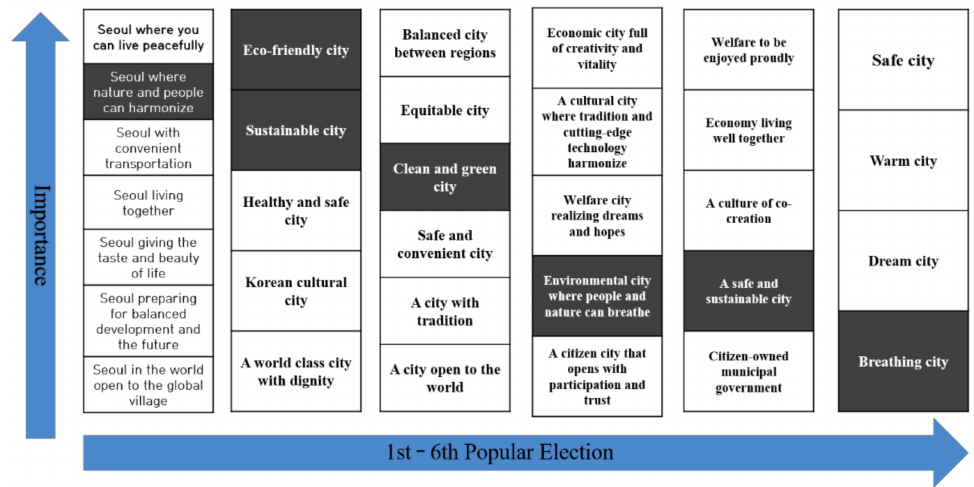
Figure 8. Changes in the Seoul Municipal Government’s policies